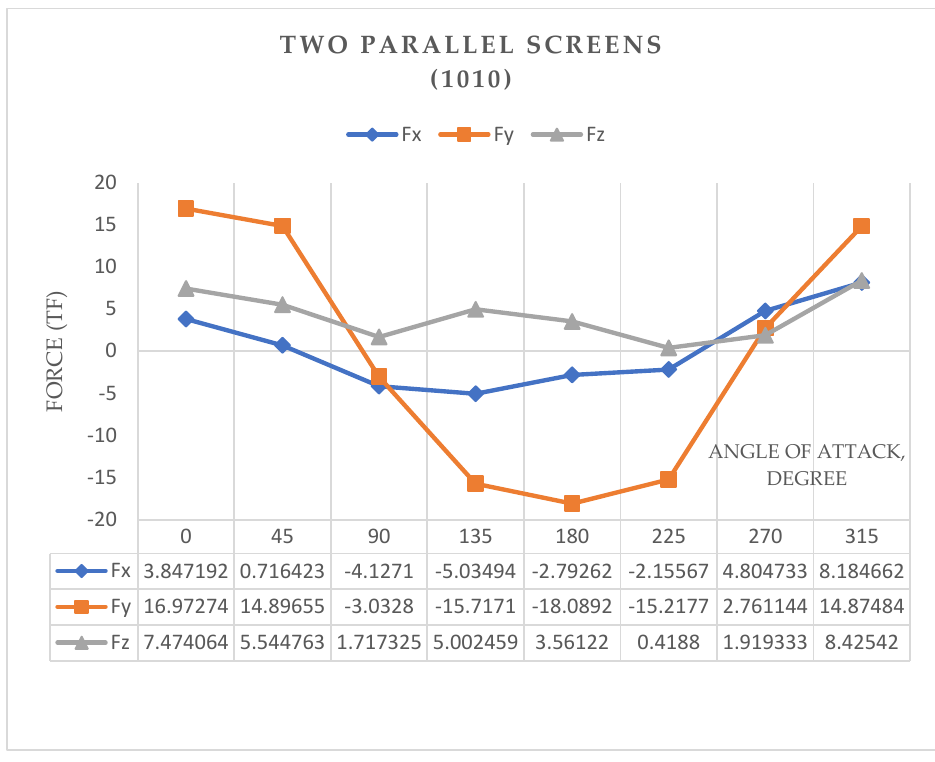
Figure 10. Force curves of Fx, Fy, Fz (tf) when the angle of attack is changed from 0° to 360° for an aeroelastic model with two parallel screens, Option (1010).